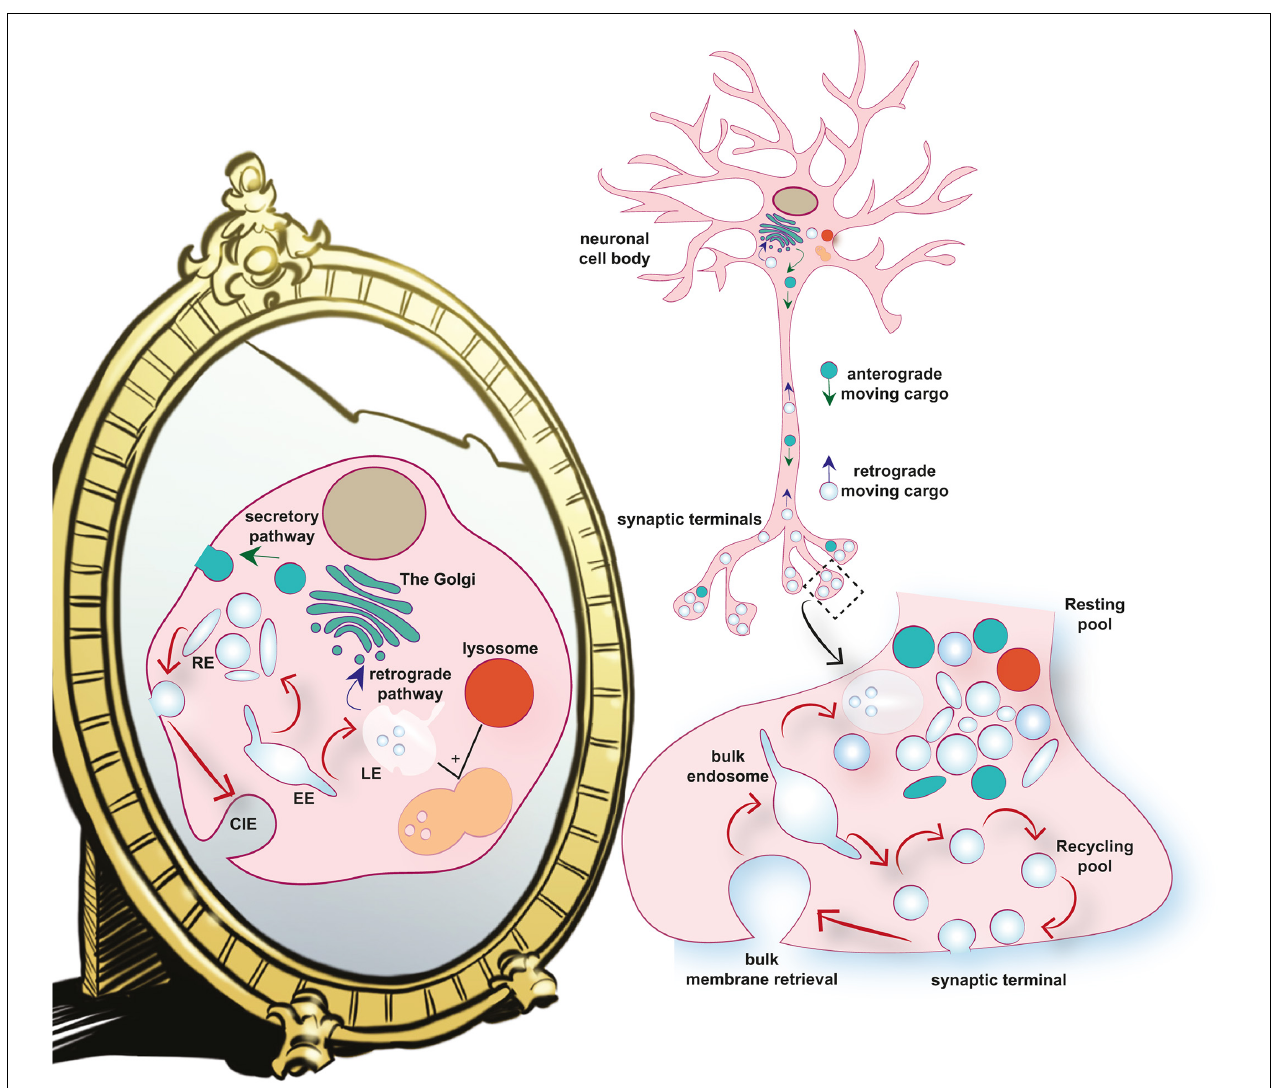
FIGURE 1 | The SV life cycle as a mirror image of the general endolysosomal system. (A) The endolysosomal system consists of a set of membrane-bound compartments that undergo dynamic interconversion. At the center of this system is the Golgi apparatus, which is a steady-state organelle that apart from a central sorting hub in the secretory pathway, functions as an important quality control checkpoint that constantly receives cargo from the plasma membrane and the peripheral endosomes. The endolysosomal system is comprised of: (1). Early endosomes (EEs). EEs are organelles that receive membrane cargos and solutes from the extracellular environment through endocytosis. The main mode of endocytosis in most cells is clathrin-independent endocytosis (CIE). The EE sorts these cargos into recycling or degradative compartments of the cell. (2). Recycling endosomes (REs). REs are compartments involved in the slow constitutive and regulated recycling of cargo to the plasma membrane. (3). Late endosomes (LEs). The central role of LEs is sorting of ubiquitinated membrane proteins into intralumenal vesicles which form multi vesicular bodies (MVBs). MVBs fuse with lysosomes to form a degradative compartment in which protein cargos and intralumenal vesicles are degraded. LEs are also involved in the retrograde retrieval of cargo molecules from the plasma membrane and other endosomes to the Golgi apparatus. (4). Lysosomes are membrane-bound organelles that degrade and recycle cellular waste. In addition, they play an important role in cellular signaling and